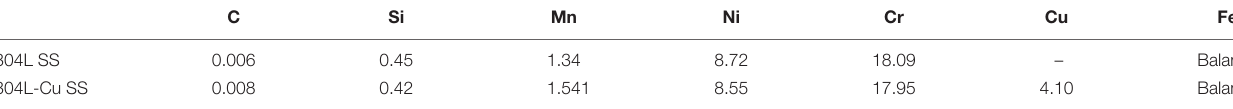
TABLE 1 | Chemical compositions of 304L and 304L-Cu SS (wt.%). C Si Mn Ni